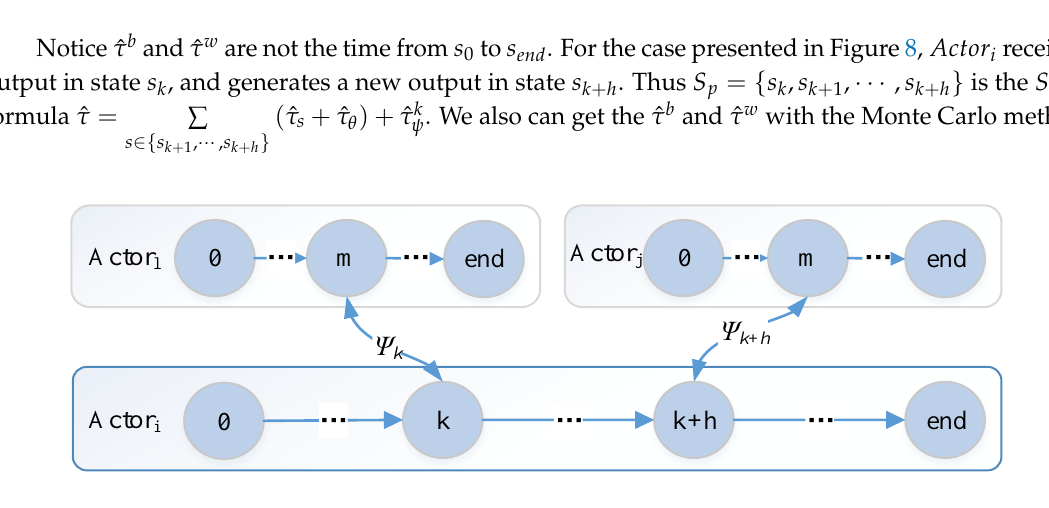
Figure 8. The interaction of actors.